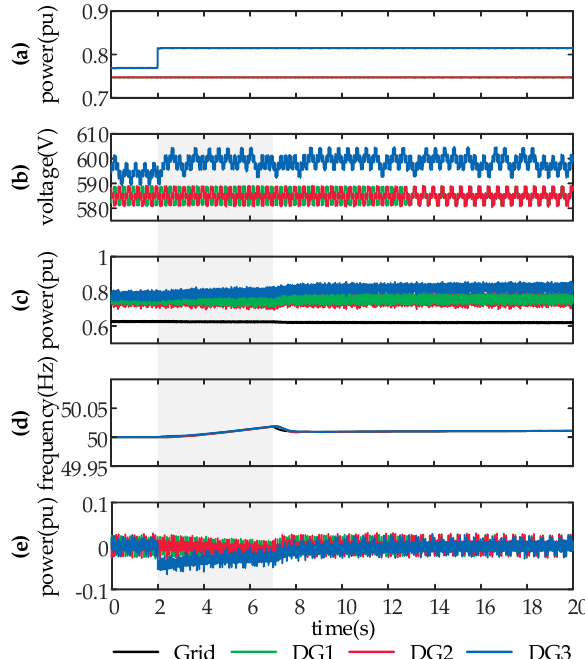
Figure 13. Responses to a step of solar irradiance when the proposed PV systems are applied as DG1–DG3: ( a ) Power generated from the PV array; ( b ) dc link voltage of the inverter; ( c ) output active power; ( d ) frequency response; ( e ) exchanged power between the ES unit and dc link. Table 4. Advantages of the proposed grid-supporting PV system as compared with the conventional PV system. PV Conventional Proposed Features PV System PV System